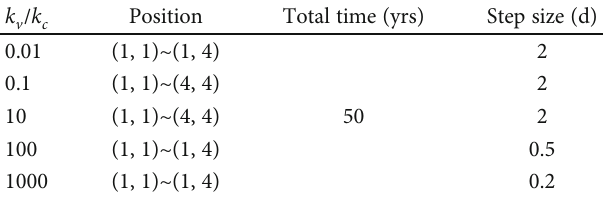
Table 2: Setup of the simulation cases, with a permeability contrast ranging from 0.01 to 1000, and di ff erent positions to placing the low (high)-permeability region. The positions are marked in Figure